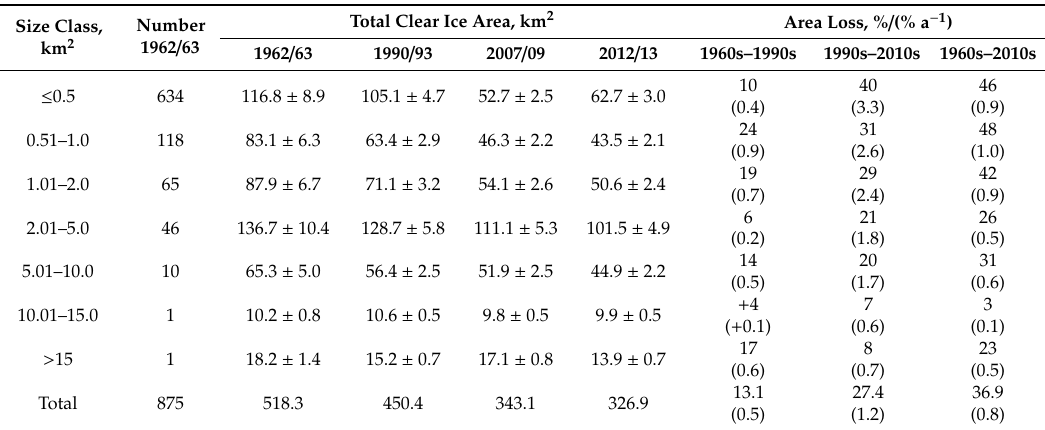
Table 6. Changes in glacier area by size